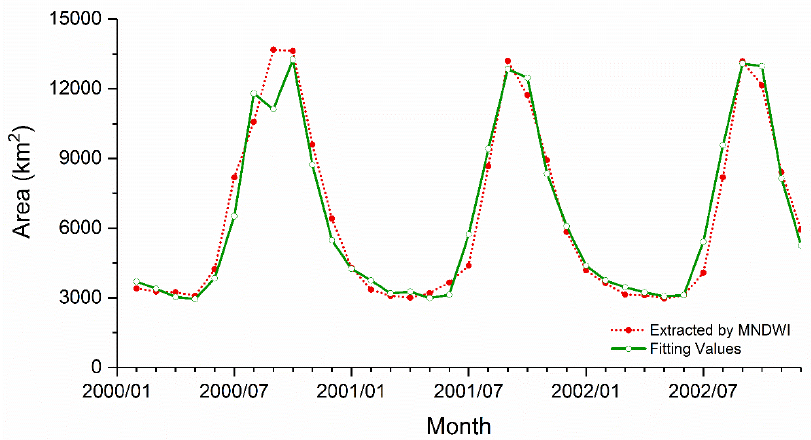
Figure 9. Comparison between the Simulated Water Area and Extracted Water Area by Modified Normalized Difference Water Index (MNDWI).